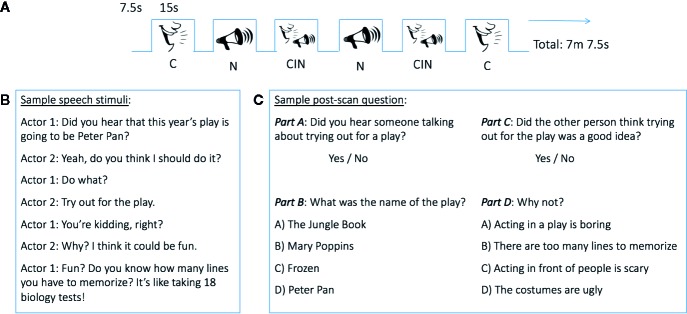
Experimental design. (A) Block design functional MRI (fMRI) task. (B) Example of a conversation heard during fMRI data acquisition. (C) Sample of post-scan questions. CIN, conversation-in-noise; C, conversation; N, noise.